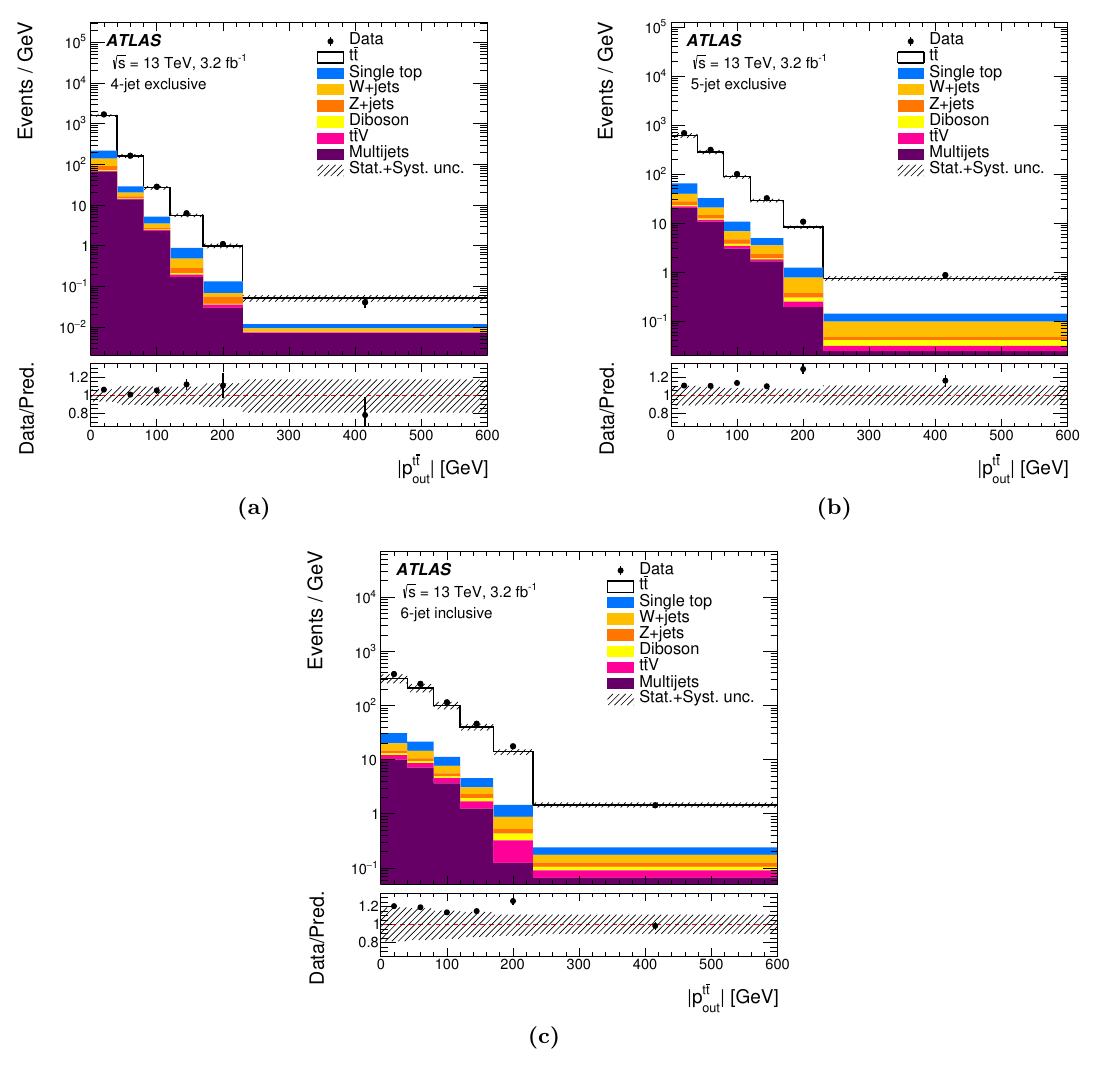
(cid:12) (cid:12) (cid:12) (cid:12) Figure 6 . Distributions of p t (cid:22) t at reconstruction level: (a) 4-jet exclusive, (b) 5-jet exclusive out (cid:12) (cid:12) and (c) 6-jet inclusive con(cid:12)gurations. Data are compared to the sum of signal and background pre- dictions using the nominal sample as the t (cid:22) t signal model. The hatched area indicates the combined statistical and systematic uncertainties in the total prediction, excluding systematic uncertainties related to the modelling of the t (cid:22) t production. Events beyond the range of the horizontal axis are included in the last